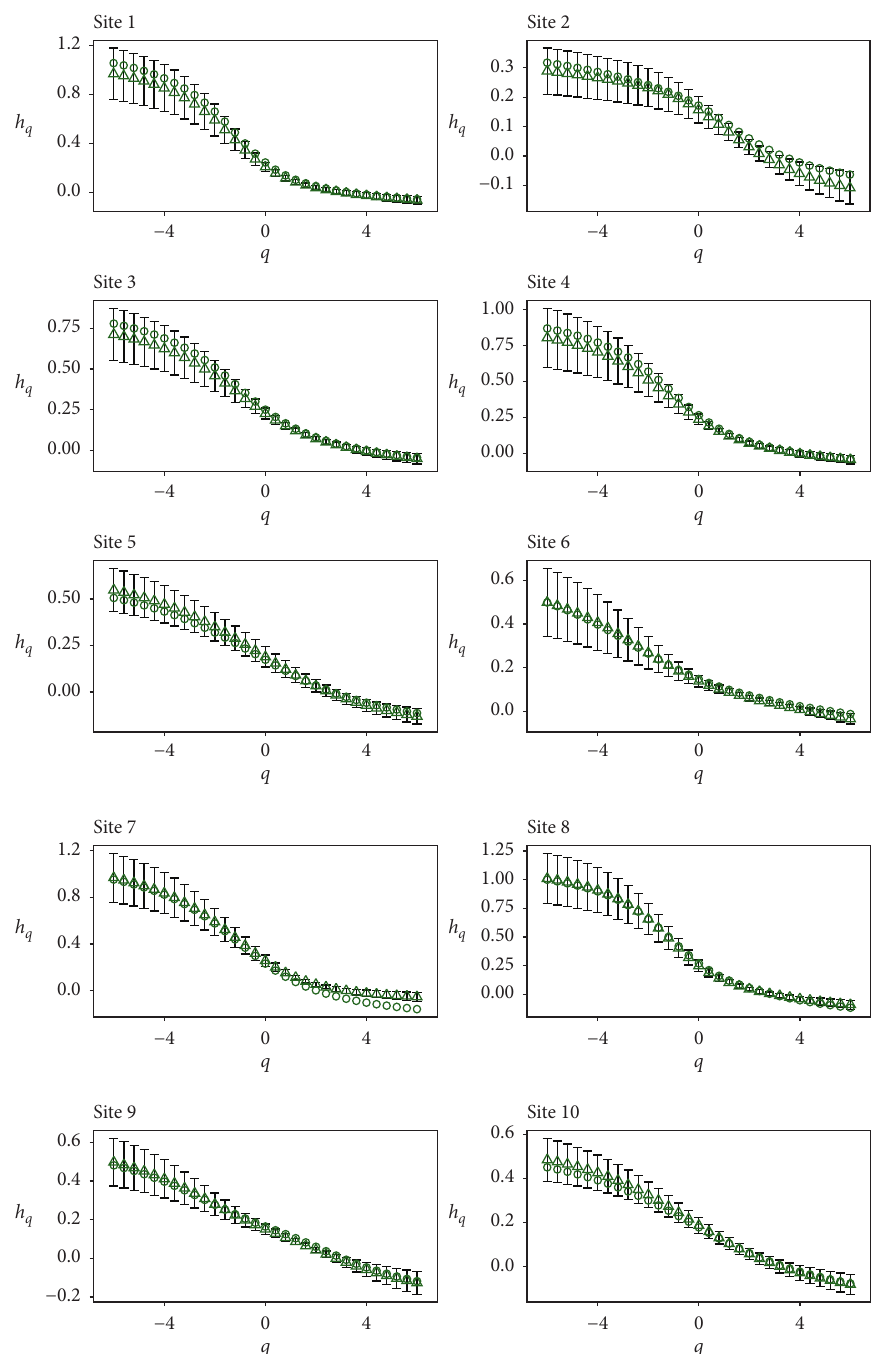
Figure 5: Comparison of values of the generalized Hurst exponent h ( q ) , respectively, obtained from the preprocessed daily average river X levels and its half-dividing series. Different symbols indicate the corresponding different results: triangles for results of the preprocessed daily average river levels and circles for its half-dividing series. The errors bars for the preprocessed daily average river levels are based on the linear least square fit. All the errors bars reveal 95% confidence